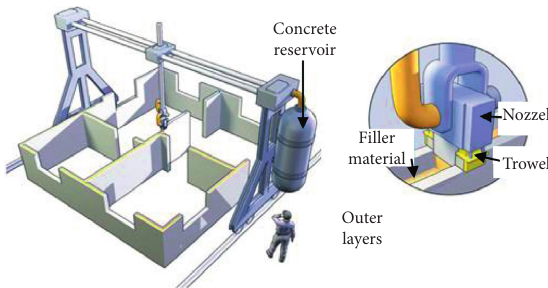
Figure 2: Contour crafting in construction operation [8].